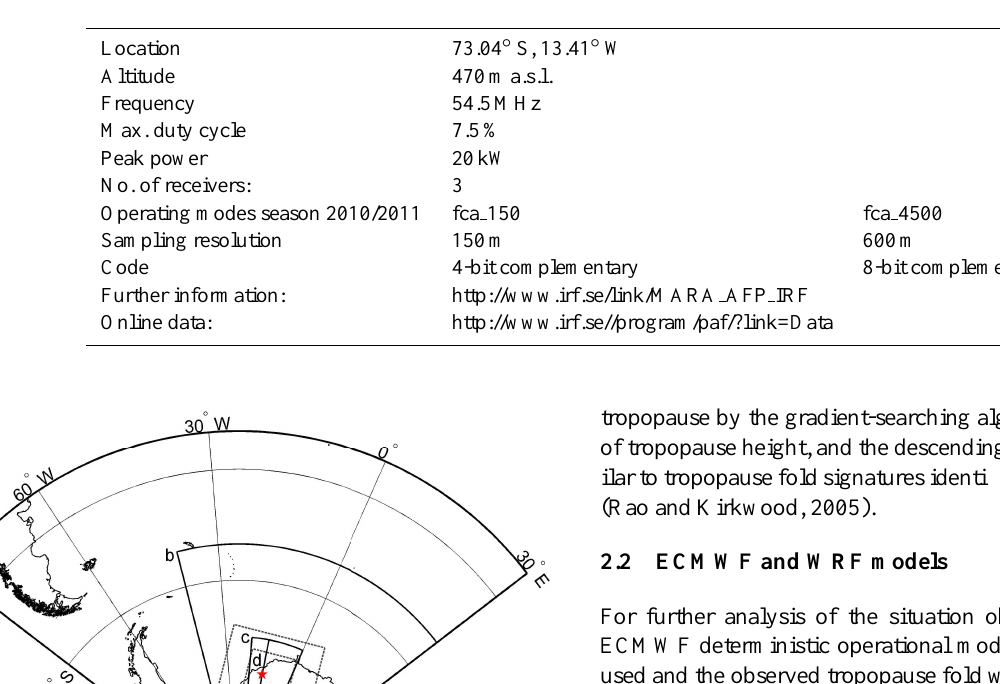
Table 1. MARA: technical details and radar operating modes for the summer season 2010/2011.